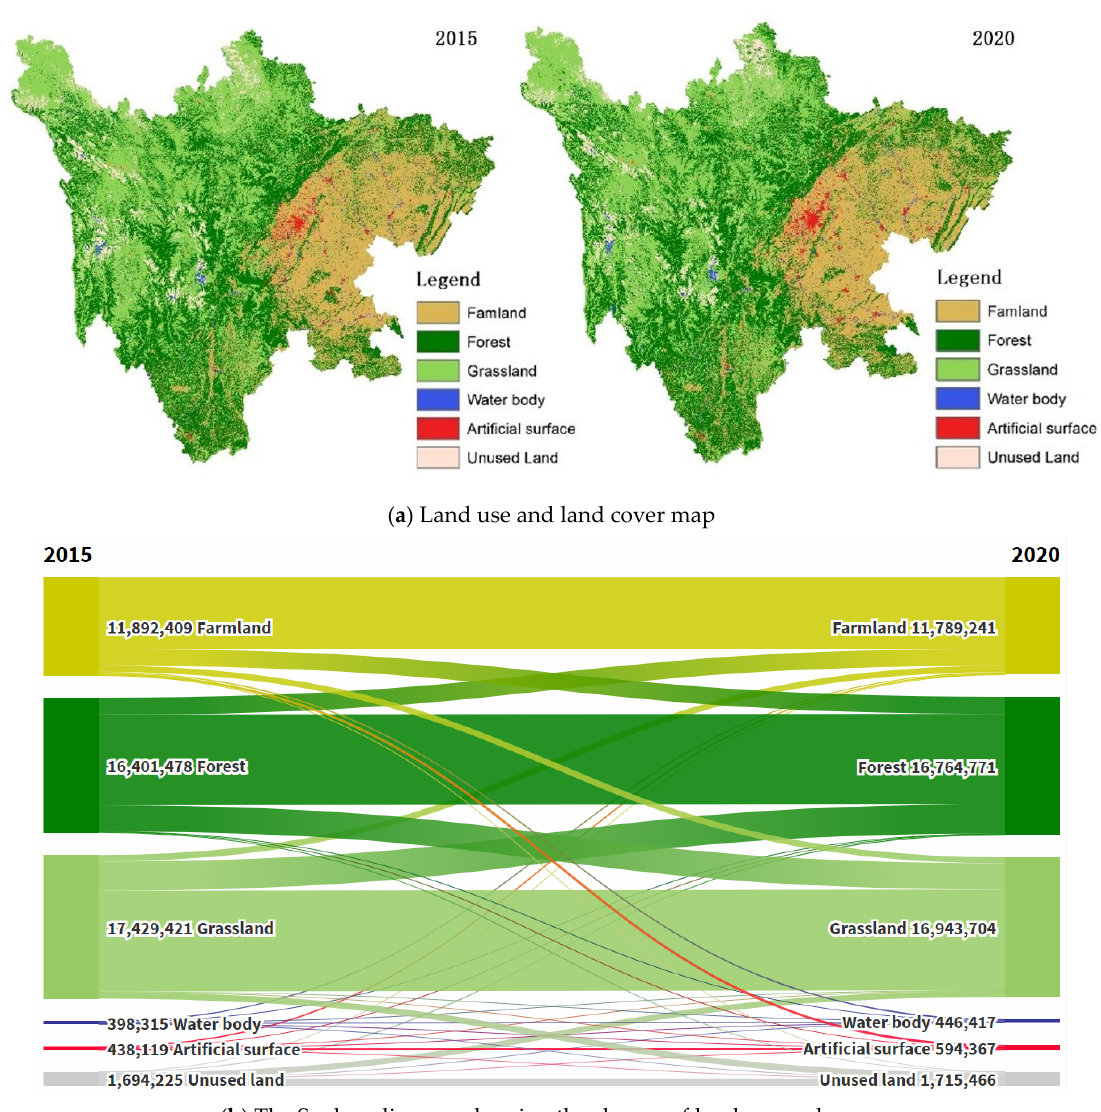
Figure 5. The change of land use and cover of Sichuan province in 2015 and 2020.